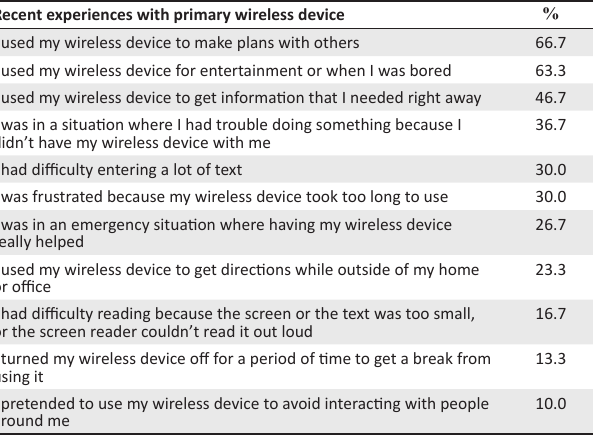
TABLE 8: Recent experiences with primary wireless device ( N =